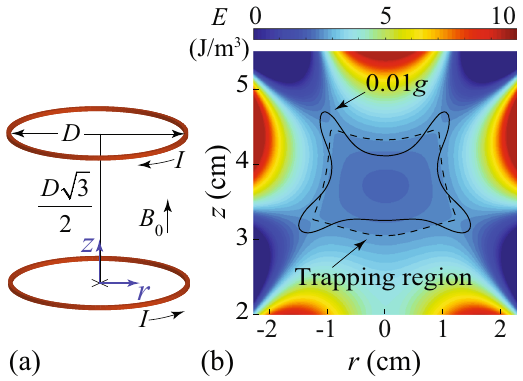
Fig. 2 Functional volume of our MLS design using a gradient- fi eld Maxwell coil. a Schematic of the gradient- fi eld Maxwell coil with a diameter D = 8 cm in the presence of an applied uniform fi eld B 0 . b Calculated speci fi c potential energy E ( r ) of a small water sample placed in the magnetic fi eld for I = 112.6 kA and B 0 = 24 T. The origin of the coordinates is at the center of the bottom current loop. The black dashed contour denotes the boundary of the trapping region, and the black solid contour shows the low-force region (i.e., acceleration <0.01 g ).